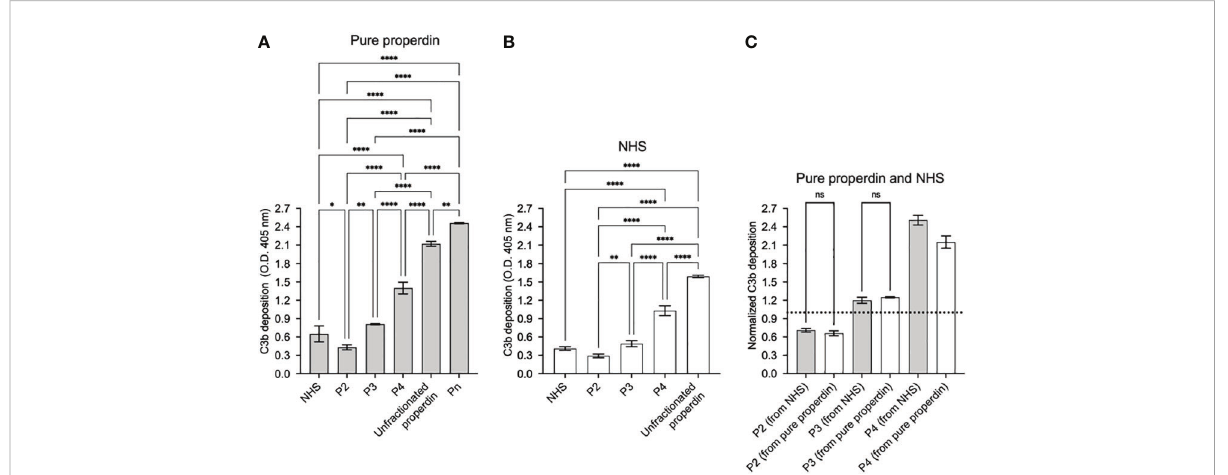
FIGURE 4 Properdin functional ELISA can distinguish function between properdin oligomers derived from pure properdin and serum. Properdin function was quanti fi ed by the properdin functional ELISA where the readout was C3b deposition as described in “ Materials and Methods ” (section 2.8.1). Data is graphed minus background of samples containing no properdin during the properdin capture step. All samples were tested at equivalent concentrations (200 ng/ml). Properdin function was quanti fi ed in properdin oligomer samples (P n , P 4 , P 3 , and P 2 ) that were separated from pure properdin (A) and in P 4 , P 3 , and P 2 from NHS (B) . Both (A) and (B) include assessment of function of unfractionated NHS and unfractionated pure properdin as controls. The data is a representative of 3 experiments and is graphed as mean and standard deviation of triplicates. (C) C3b deposition normalized to an internal plate control (NHS, dotted line) for P 2 , P 3 , and P 4 derived from pure properdin (as shown in A ) and NHS (as shown in B ). Signi fi cant differences in C3b deposition between samples was assessed by one-way ANOVA with Tukey ’ s multiple comparison